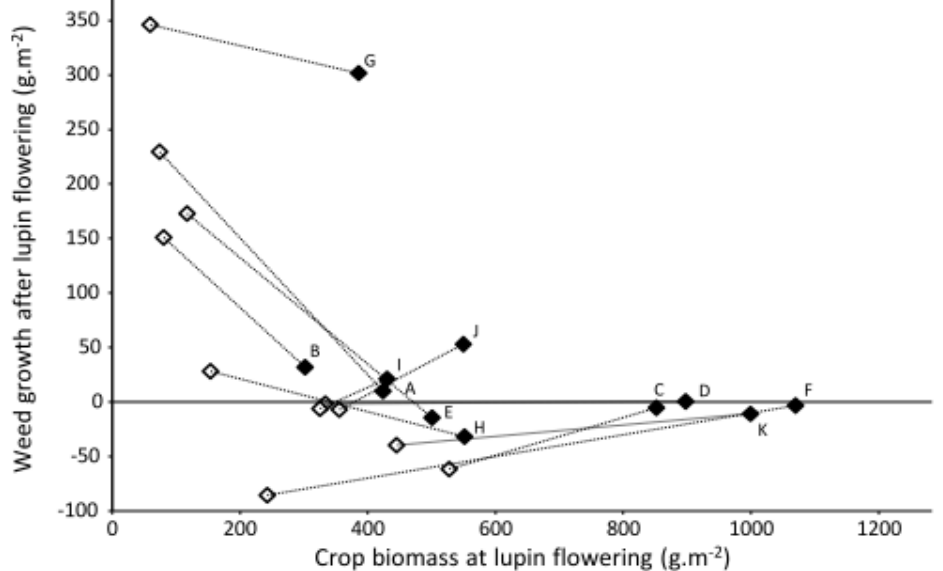
Figure 6. Weed growth after flowering against crop biomass at lupin flowering. Open symbols refer to lupin sole crops and full symbols refer to intercrops. Letters next to points identify study sites. The mean proportion of triticale in the intercrop biomass was 75% at lupin flowering (CV: 14%) This proportion decreased to 59% at maturity and with a higher variability (CV = 28%). The addition of triticale reduced the proportion of weeds in total plant biomass. At flowering, the weed biomass represented 33% of the canopy in pure lupin and 7% in the intercrop. At maturity, the weed biomass represented 24% of the canopy in pure lupin and 8% in the